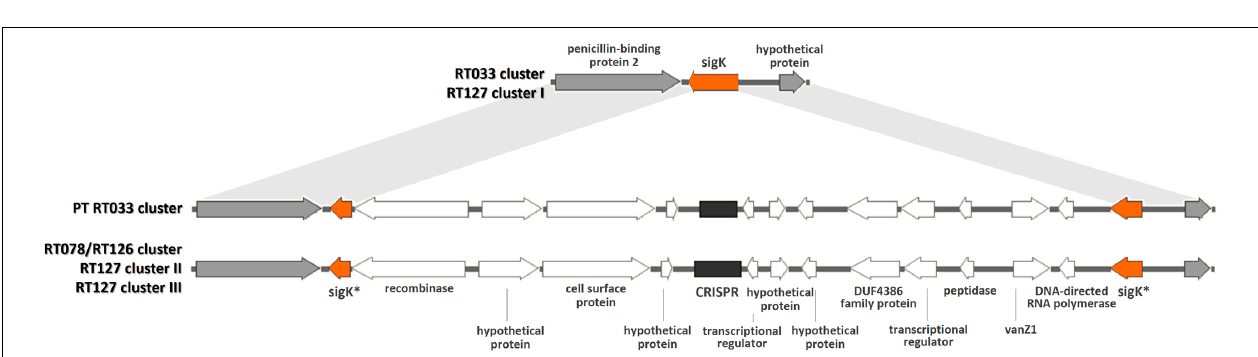
FIGURE 3 | PaLoc genetic diversity within the Clostridioides difficile clade 5 ST11 lineage. For all clusters, ORFs orientation is depicted by arrows, while PaLoc region is highlighted by a yellow box with tcdR , tcdB, tcdE , tcdL and tcdA genes differently colored. The Tn6218-like element, exclusively found in the classic RT033 cluster, is shown in yellow arrows. Flanking genes (homologous to all clusters) of the PaLoc-containing region are represented by gray arrows, where extremes designated according to RT078 reference M120 genome (NC017174.1).